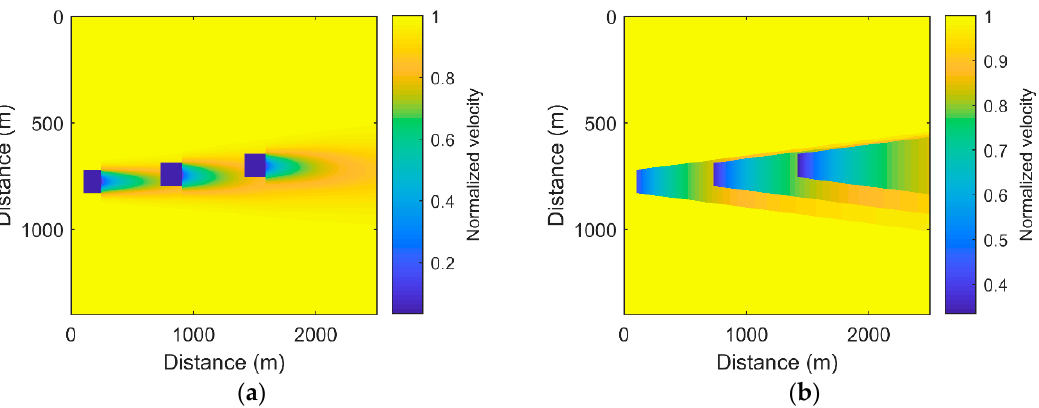
Figure 12. Streamwise wake of the three turbine array under the partial wake condition: ( a ) Gaussian- based analytical wake model and ( b ) Jensen model.